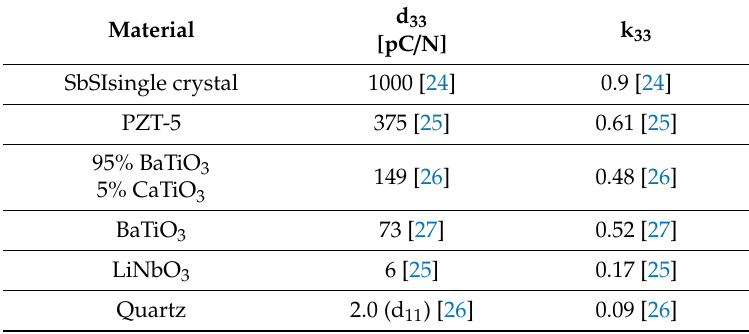
Table 1. Comparison of piezoelectric properties of SbSI and other materials: d 33 —piezoelectric coe ffi cient, k 33 —electromechanical coupling factor (into “33”